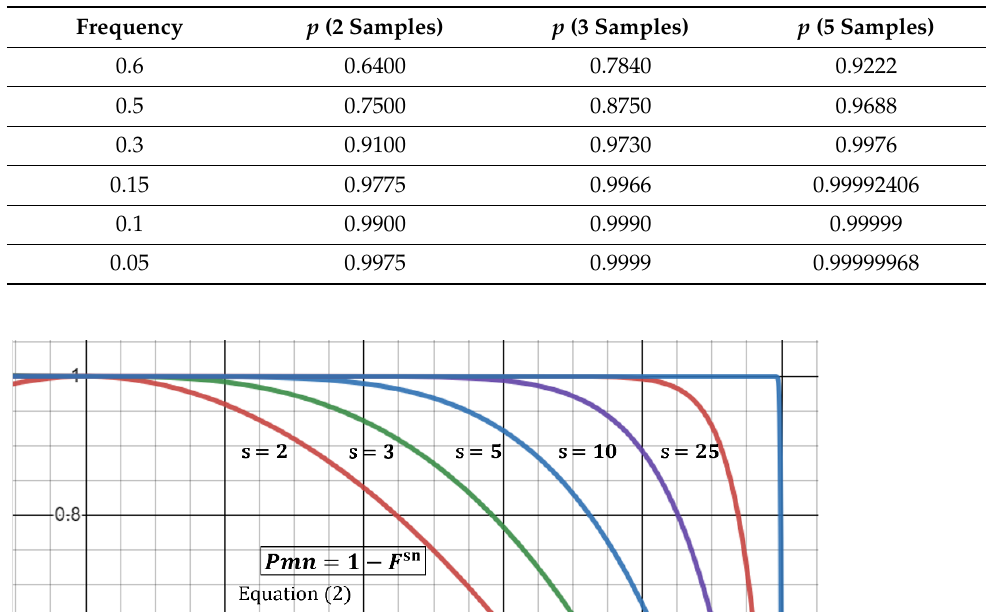
Table 1. P of non-random Association (Frequency vs. Sample Number).